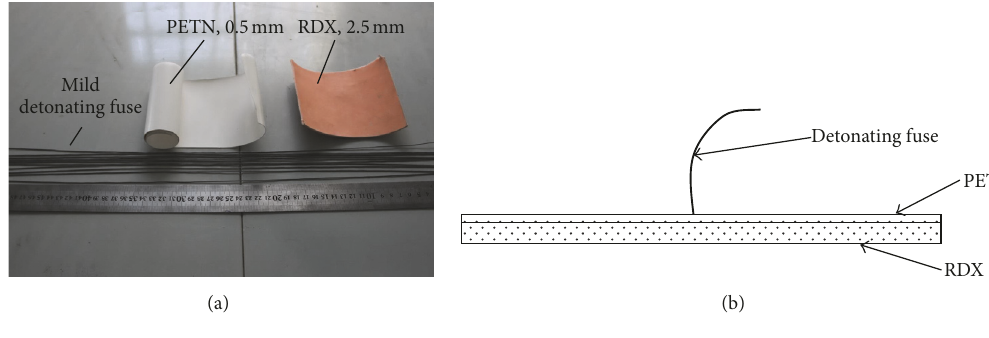
Figure 2: Flake-like charges and detonation cores.